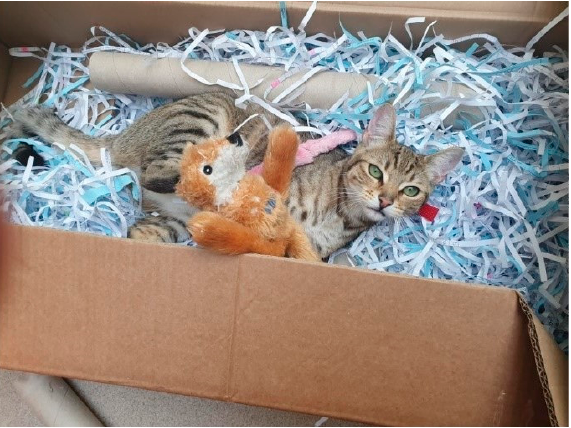
Figure 6. A cat at Waltham enjoying enrichment in a toy-filled cardboard box.